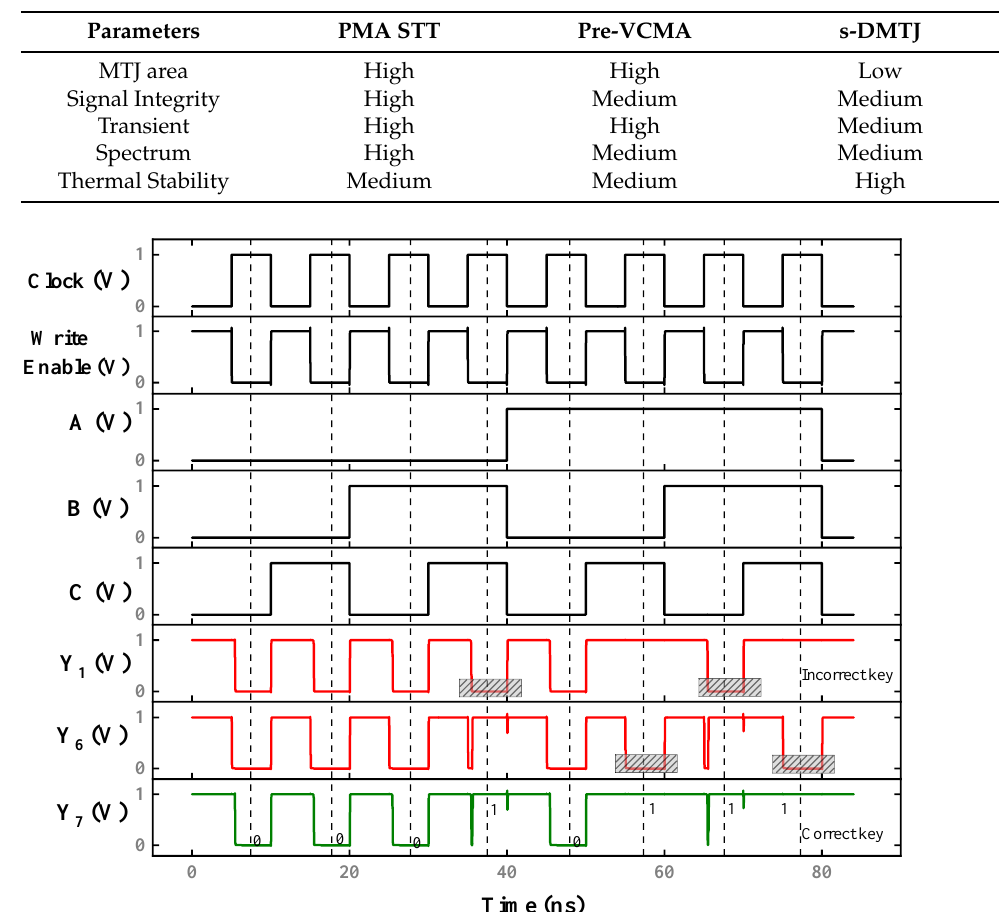
Table 6. Short Comparison with other 2T MTJs for logic locking.